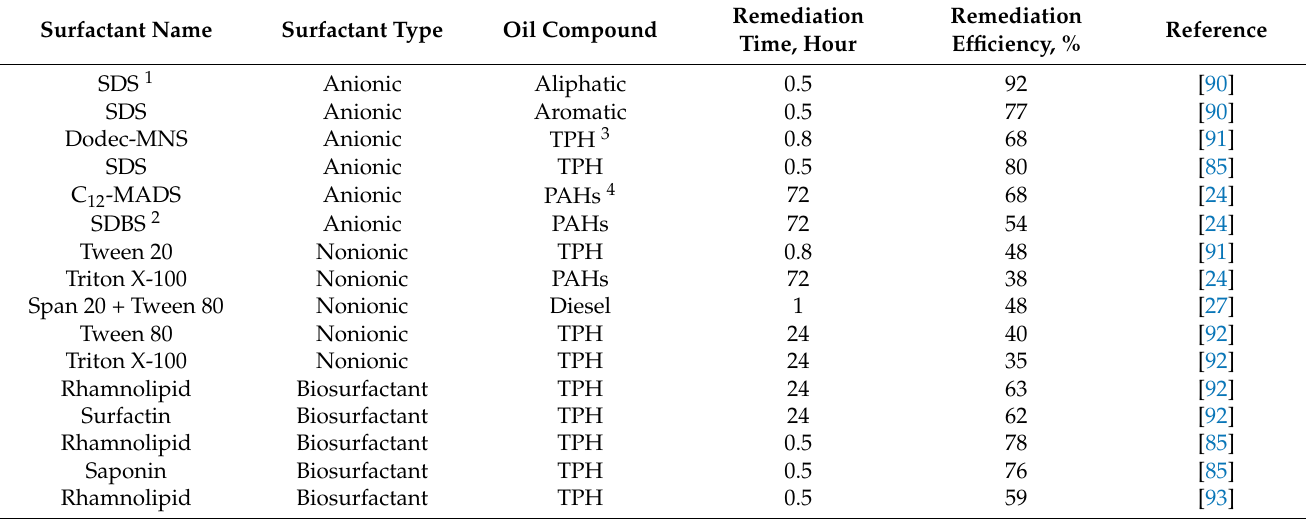
Table 2. Use of some surfactants for the removal of oil pollutants in